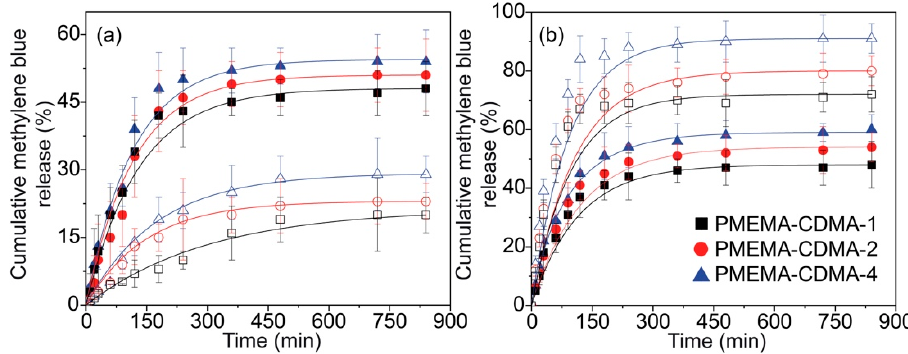
Figure 4. Release profiles of methylene blue from PMEMA brush-gels under pH > pKa ( a ) and pH < pKa ( b ) conditions at room temperature (filled symbols) and 40 °C (open symbols).